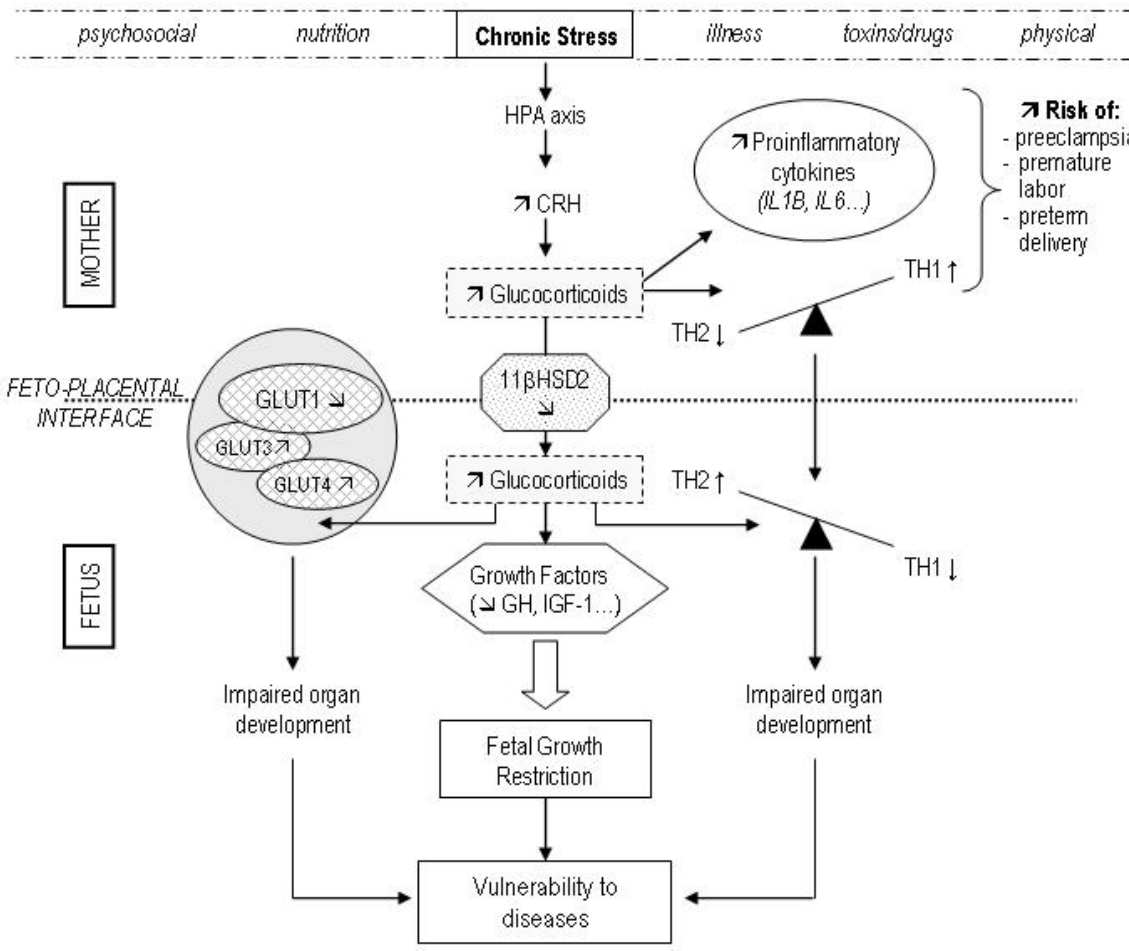
FIGURE 2. Consequences of chronic gestational stress at the feto-placental interface. Chronic stress during pregnancy, whether physical, psychosocial, nutritional, immune, or toxic, activates the maternal HPA axis, notably by increasing the production of corticotrophin-releasing hormone (CRH) and glucocorticoid (GC). Such changes within the maternal organism have been shown to increase the production of proinflammatory cytokines, such as interleukin (IL) 1B and IL-6[62], thereby shifting the T helper (Th) 1/Th2 balance towards a Th-2 proinflammatory profile, which has been associated with the occurrence of preeclampsia and premature labor/preterm delivery[254]. The chronic gestational stress alters fetal development–altered transfer of nutrients and/or hormones through the placenta. In this case, the glucose transport is detrimental, leading to impaired organ development. The excess GC in the feto-placental unit derives from the elevated maternal GC levels. The transfer of maternal GC is facilitated by the decrease in both activity and expression of the 11 β -HSD2, a placental enzyme that functions to protect the fetus from an excessive transfer of maternal GC. All of these factors intervene directly or indirectly in the development of intrauterine growth retardation. Gestational stress may thus alter the neuroendocrine programming, leading to low birth weight progeny that present an increased vulnerability to develop long- term metabolic and psychiatric diseases. 11 β -HSD2: 11 β -hydroxysteroid dehydrogenase type 2; GH: growth hormone; GLUT: glucose transporter; HPA: hypothalamic-pituitary-adrenal axis; IGF-1: insulin growth factor type 1; TH: T helper lymphocyte